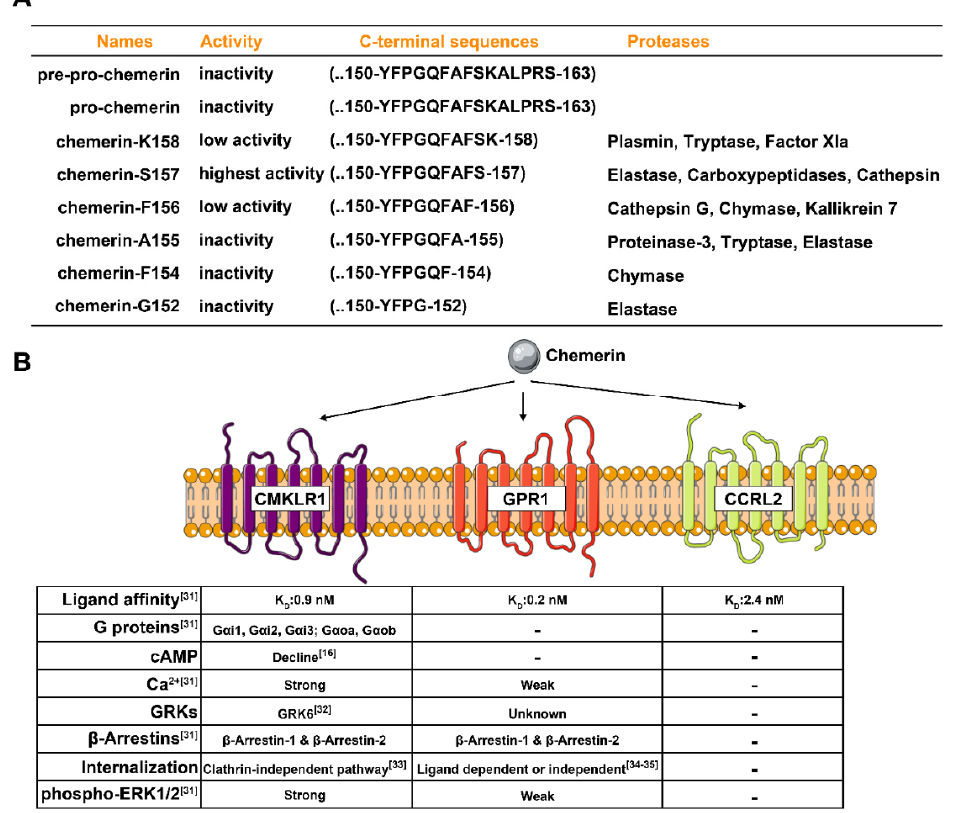
Figure 1. The characteristics of chemerin isoforms and the three receptors. ( A ) The characteristics of known chemerin isoforms are summarized based on Buechler et al. [19] and Ernst et al. [20]. ( B ) The known characters of CMKLR1, GPR1, and CCRL2 in terms of chemerin affinity and certain GPCR signaling features are summarized.